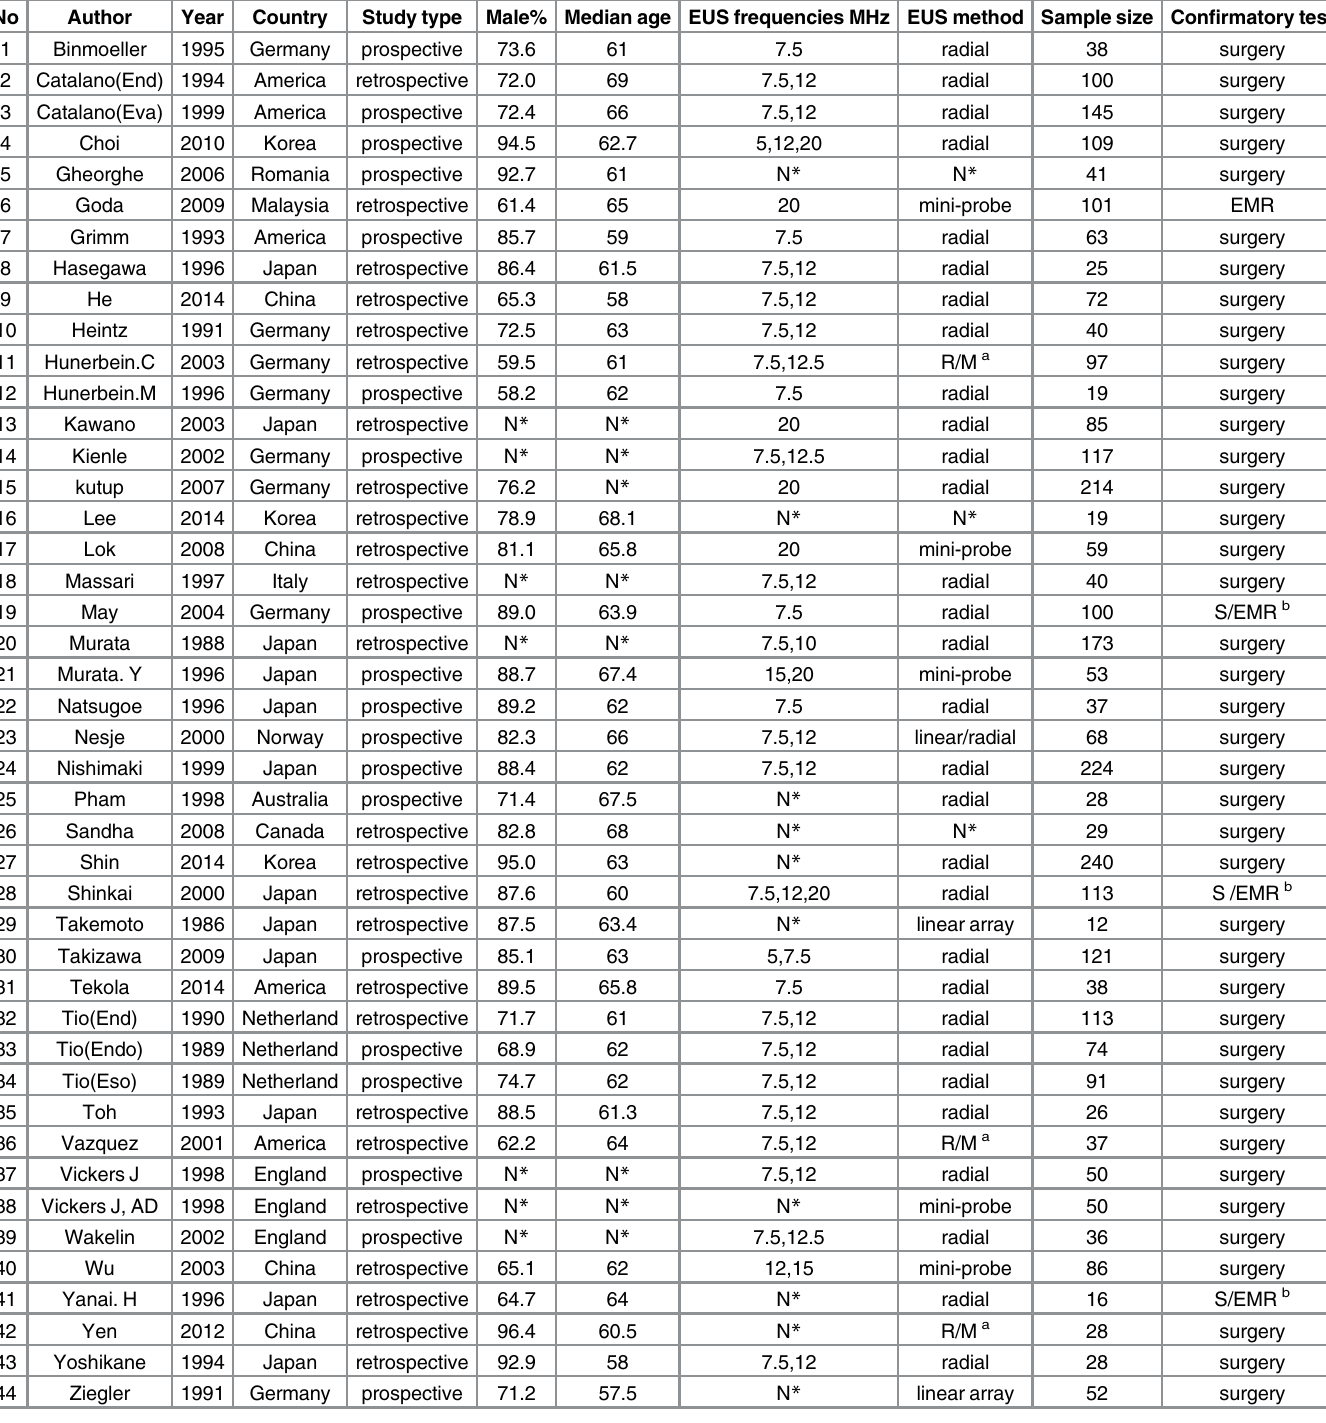
Table 1. Characteristic of included